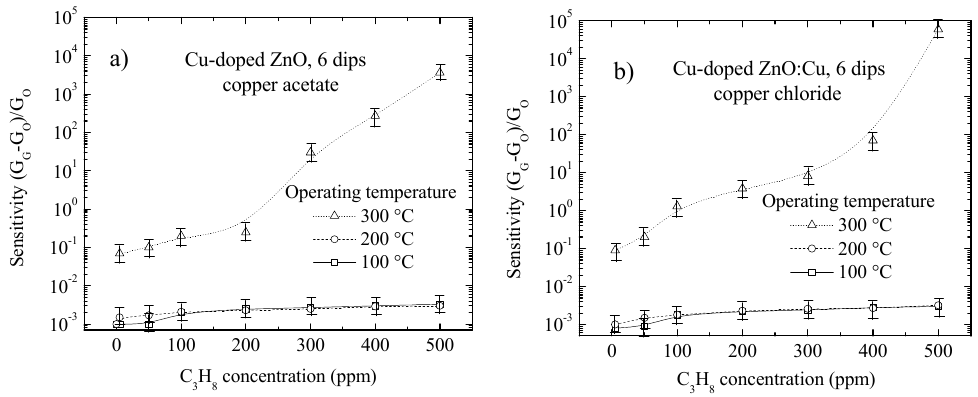
Figure 4. Variation of the sensitivity with propane gas concentrations at different operating temperatures for Cu-doped ZnO films prepared from six dips in ( a ) copper acetate and ( b ) copper chloride. Materials 2016 , 9 , 87